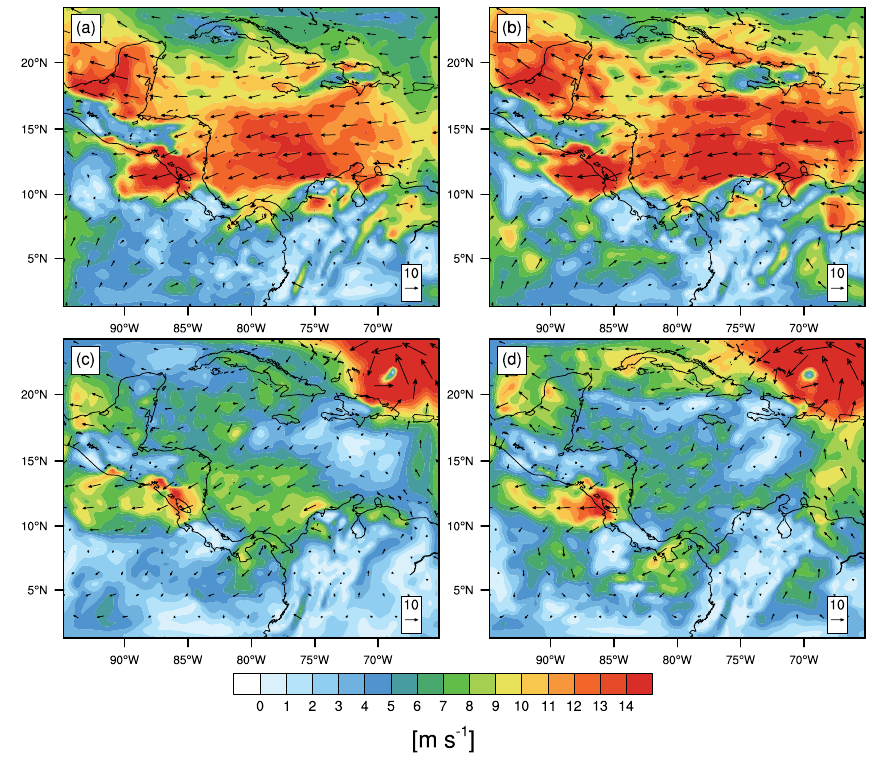
Figure 4. Wind (m s − 1 ) at 925 hPa for 11 July 2004 and 1 September 2004 at 06:00 LST as simulated by MM5v3 (D1 domain) using GrMRF ( a , c ) and KFGS ( b , d